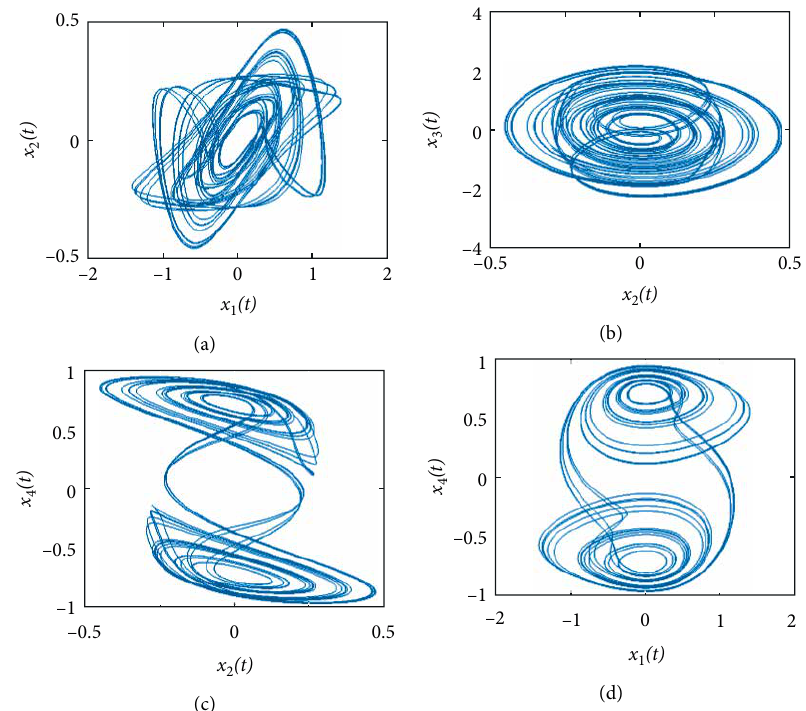
Figure 2: The chaotic attractor of FCCM, (a)